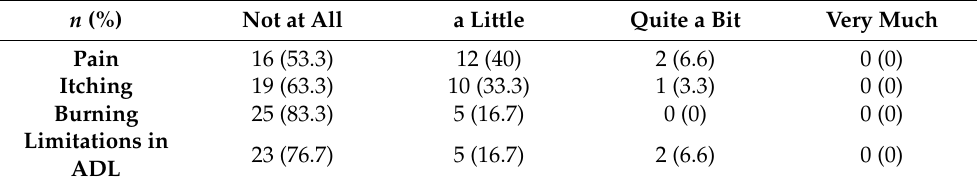
Table 3. Results of the patient-assessed modified Radiation-Induced Skin Reaction Assessment Scale (RISRAS) questionnaire upon treatment completion [21]. All items were scored on a 4-point Likert scale. n (%) Not at All a Little Quite a Bit Very Much Pain 16 (53.3)